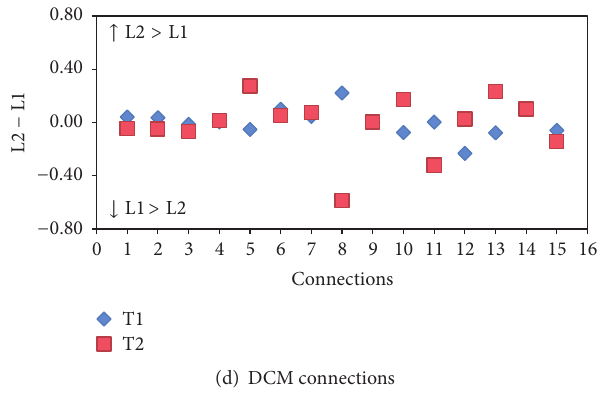
Figure 7: Patient 5. (a) An ischemic lesion in the left frontal, insula, and sylvian areas in the T1-weighted MRI image at T1. (b) Pattern of brain activation in different conditions while picture naming, with an uncorrected 𝑝 < 0.001 for the main effects. (c) Behavioral results of the combined production scores in both languages, linguistic and nonlinguistic switching scores across sessions. ∗ represents 𝑝 value < 0.05 and ∗∗ represents 𝑝 value < 0.001. (d) Differences between L1 strength values and L2 strength values for each single connection across sessions. (1) ACC to LIFGTri. (2) ACC to LIFGOrb. (3) ACC to LC. (4) LC to ACC. (5) LC to LIFGTri. (6) LC to LIFGOrb. (7) LIFGTri to LC. (8) LIFGTri to ACC. (9) LIFGOrb to LC. (10) LIFGOrb to ACC. (11) LIFGTri to LIFGOrb. (12) LIFGOrb to LIFGTri. (13) BTLA to LIFGTri. (14) BTLA to LIFGOrb. (15) BTLA to